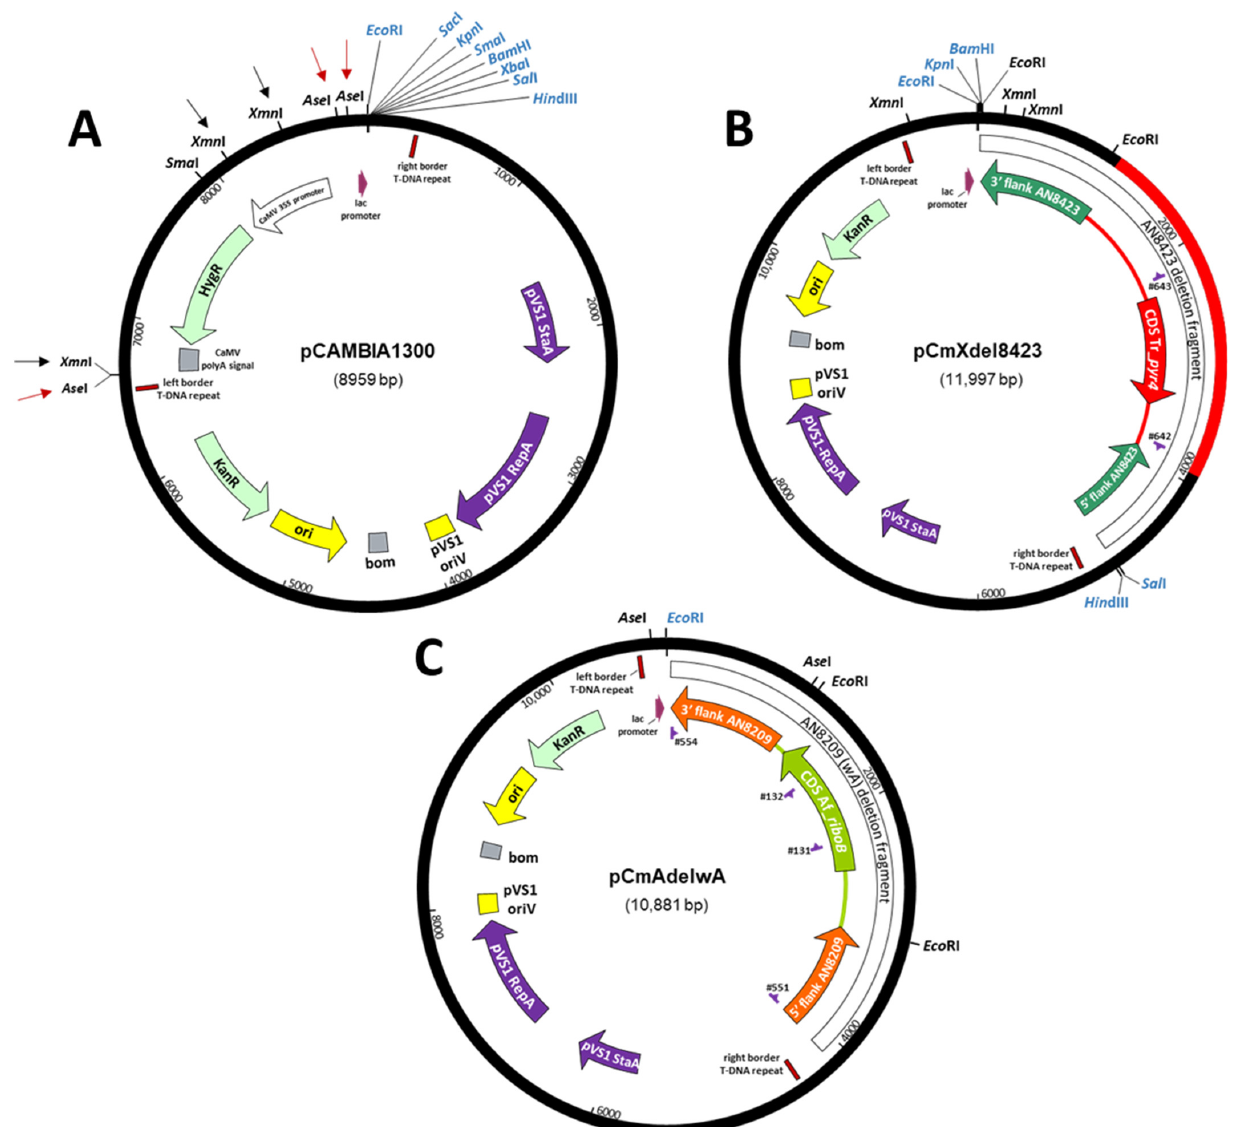
Figure 1. Plasmids used in this work. ( A ) Construction of binary vectors for implementation of ATMT in A. nidulans. A. tumefaciens binary vector pCAMBIA1300 carrying the hygromycin and kanamycin resistance genes. Black and red arrows show the restriction sites for Xmn I and Ase I: digestion with Xmn I followed by recircularisation yielded pCAMBIA-mini XmnI ; digestion with Ase I followed by recircularisation yielded pCAMBIA-mini AseI . Restriction sites in the MCS are shown in blue. ( B ) Modified binary vector for the deletion of AN8423 by ATMT. pCmXdel8423 comprises the A. tumefaciens binary vector pCAMBIA-mini XmnI into which has been cloned the AN8423 deletion fragment containing the Tr_ pyr4 expression cassette that complements the pyrG89 mutation in A. nidulans . Restriction sites of the binary vector MCS are shown in blue. ( C ) Modified binary vector for integration of Af_ riboB in wA by ATMT. pCmAdelwA comprises the A. tumefaciens binary vector pCAMBIA-mini AseI into which has been cloned the wA (AN8209) deletion fragment containing the Af_ riboB expression cassette that complements the riboB2 mutation in A. nidulans. The Eco RI site of the binary vector MCS is shown in blue.